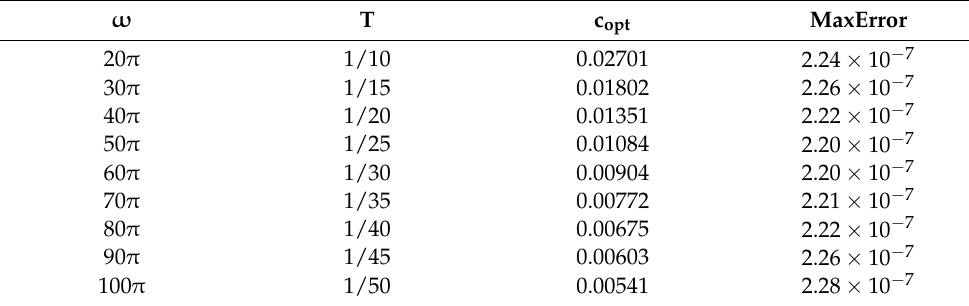
Table 9. Partial results of ω = 10k π ( k = 2, . . . ,10 ) .